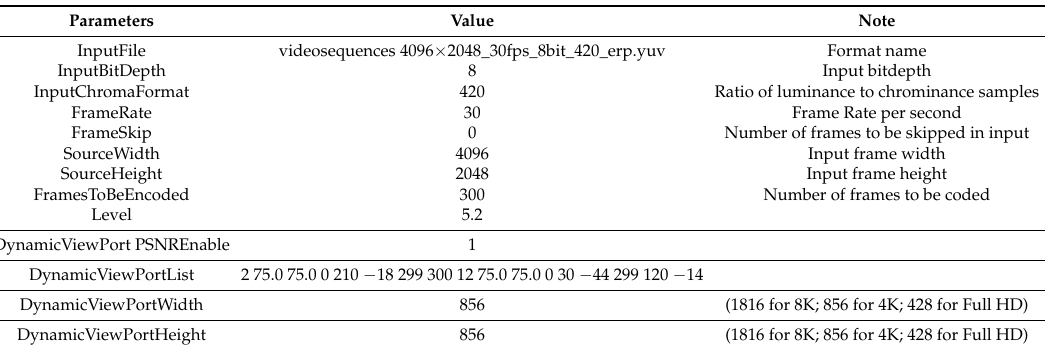
Table A2. Coding configuration of 4K 360